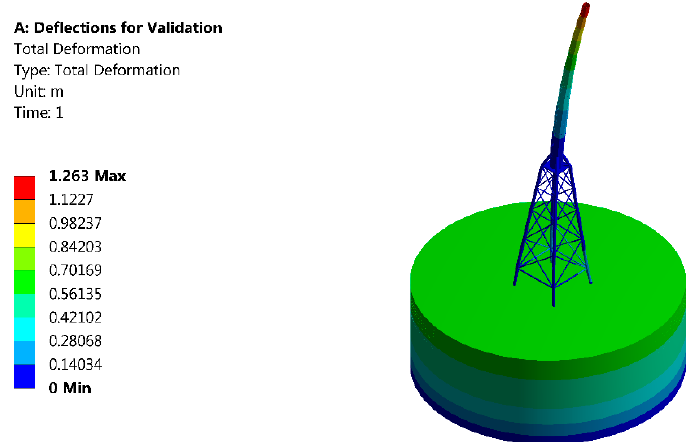
Table 7. Static deformation of the baseline 10 MW on jacket.